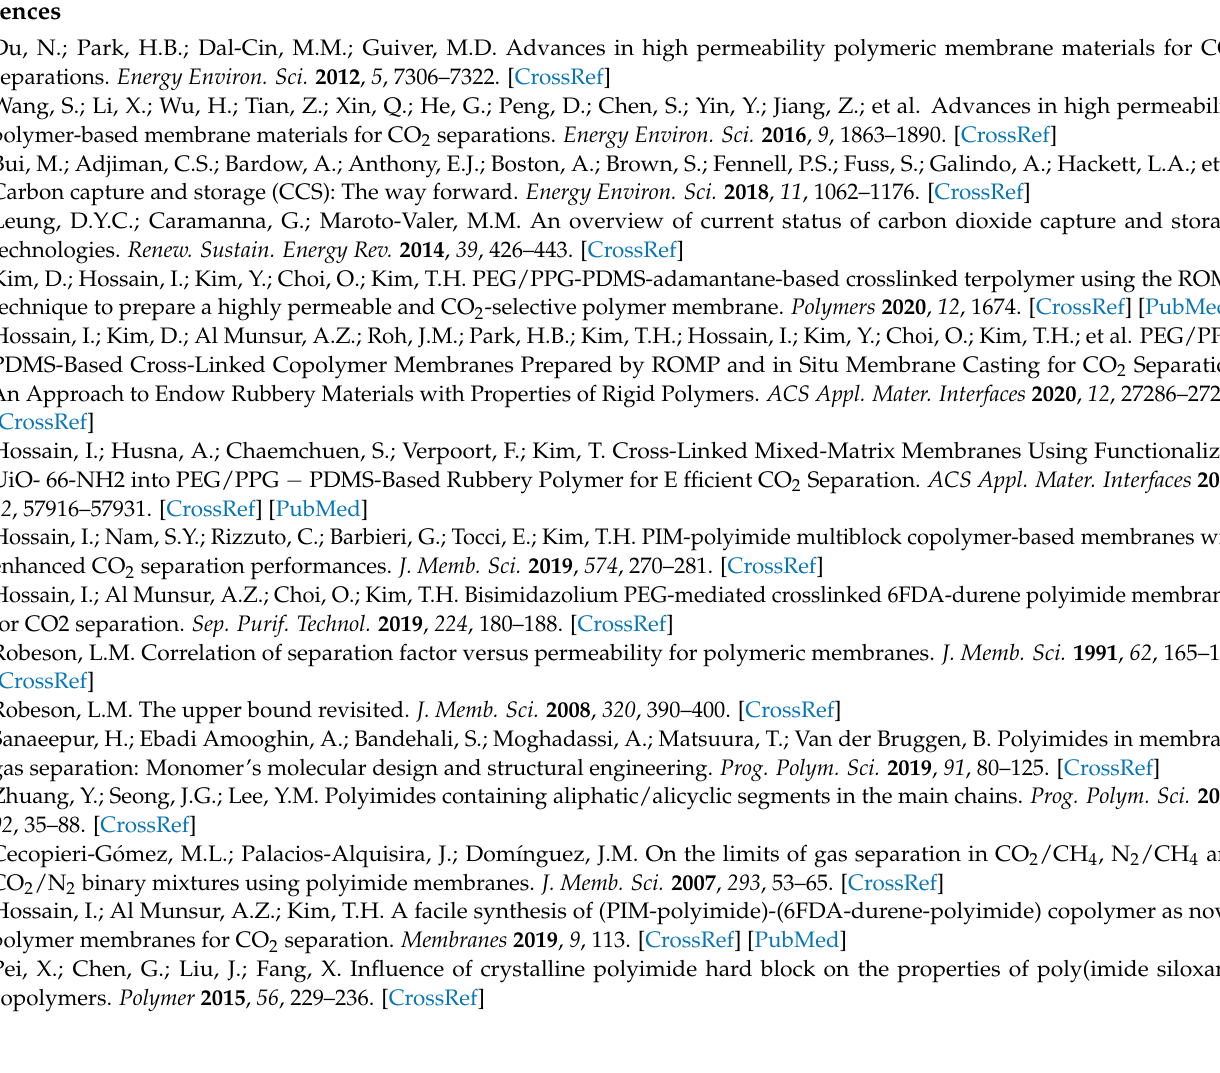
Figure S1: (a), (b) 1 H NMR spectrum and (c), (d) ATR-IR spectra of trans -dinitro-DB18C6 2 and trans - diamino-DB18C6 3; Figure S2: (a) 1 H NMR spectrum and (b) ATR-IR spectra of high PDMS-content membranes; Figure S3: (a) TGA curves of the high PDMS-content